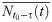
Assessing network transmission properties.(a) Defining the time-explicit steady state. Blue line—the ‘reference’ simulation ensemble, showing the mean number of informed ants Nt0-τ(t)¯ across all extant simulations initiated at t0−τ. Grey lines—100 ‘focal’ runs, initiated at the start time, t0. To be defined as having reached the steady state, a focal run must reach the blue line. The delay between the reference and the focal simulation ensembles τ, was independently determined for each network and for each {β, μ} parameter combination. (b) Calculating the probability that the information becomes self-sustaining Psustain, is defined as the proportion of focal runs that reach the steady state (grey lines). Hitting times are indicated by the red crosses. The upper rugplot indicates the hitting time distribution, with the dashed vertical line indicating its mean T¯, which marks the end of the growth phase. (c) Calculating the probability that an ant is informed, given that the information has become self-sustaining within the colony (i.e. the prevalence), Pinformed. Grey lines; focal runs that reach the steady state and that remain extant for at least 1 hour thereafter (here we use 6 minutes), are used to calculate the information prevalence. The right rugplot shows the distribution of the mean number of informed ants across all runs that remain extant for at least 1 hour after reaching the steady state, Nt0i¯. The information prevalence is given by the grand mean of this distribution, normalized by the colony size. (d) Calculating the probability that the colony loses the information after having acquired it, Plost, which is defined as the proportion of focal runs that were still extant at the mean hitting time T¯, but that later decline until no ants are informed (red crosses). For all panels shown here, β = 1, μ = 0.01.